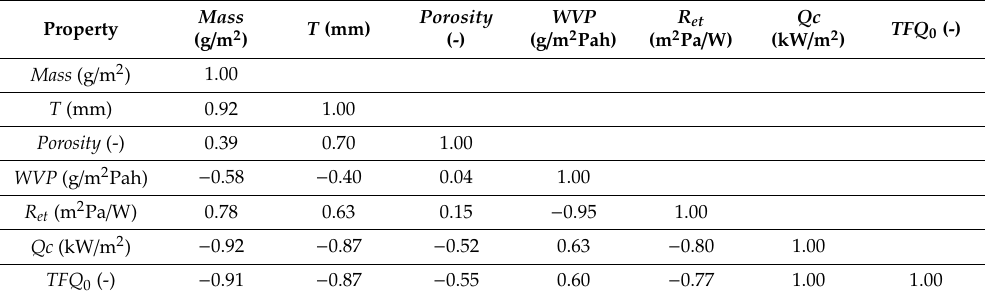
Table 6. Coe ffi cients between pairs of data.